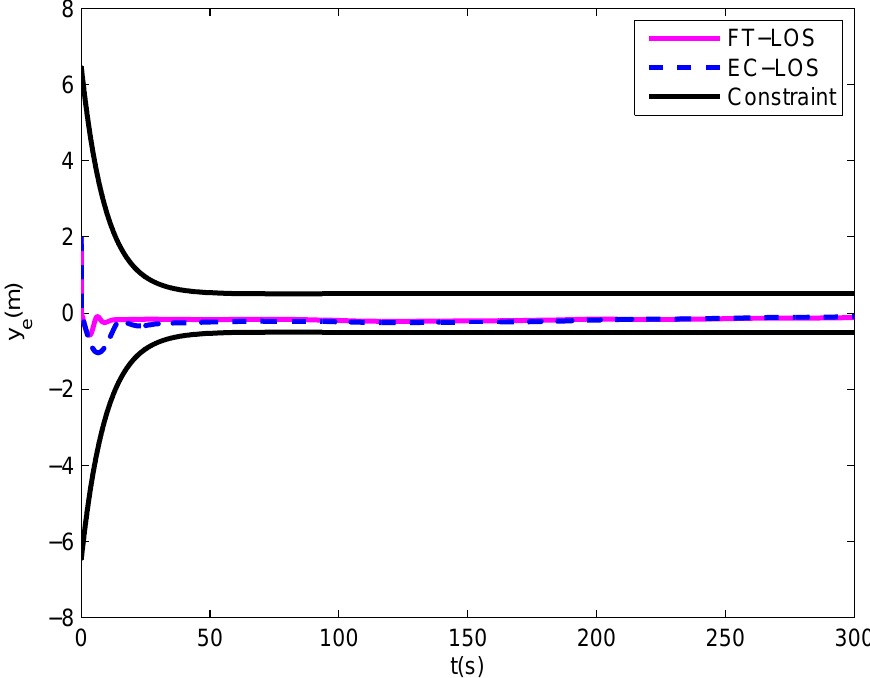
Figure 7. Cross-track error of the underactuated MSV by different guidance